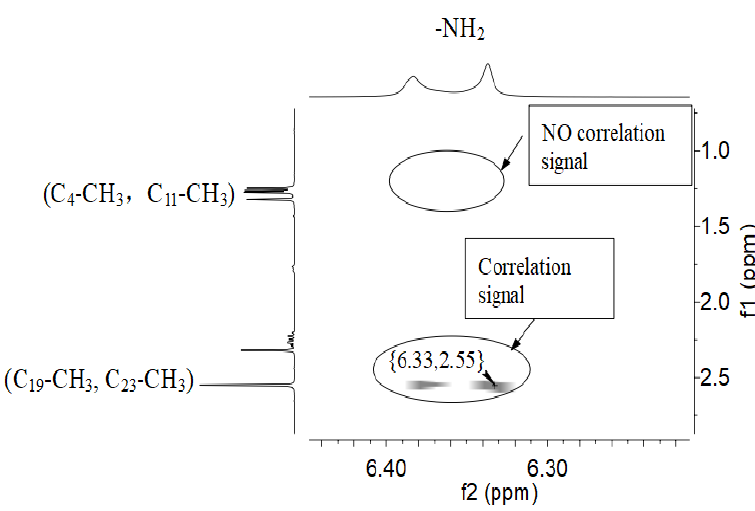
Figure 1. Expanded NOESY spectrum of the target compound 6a .